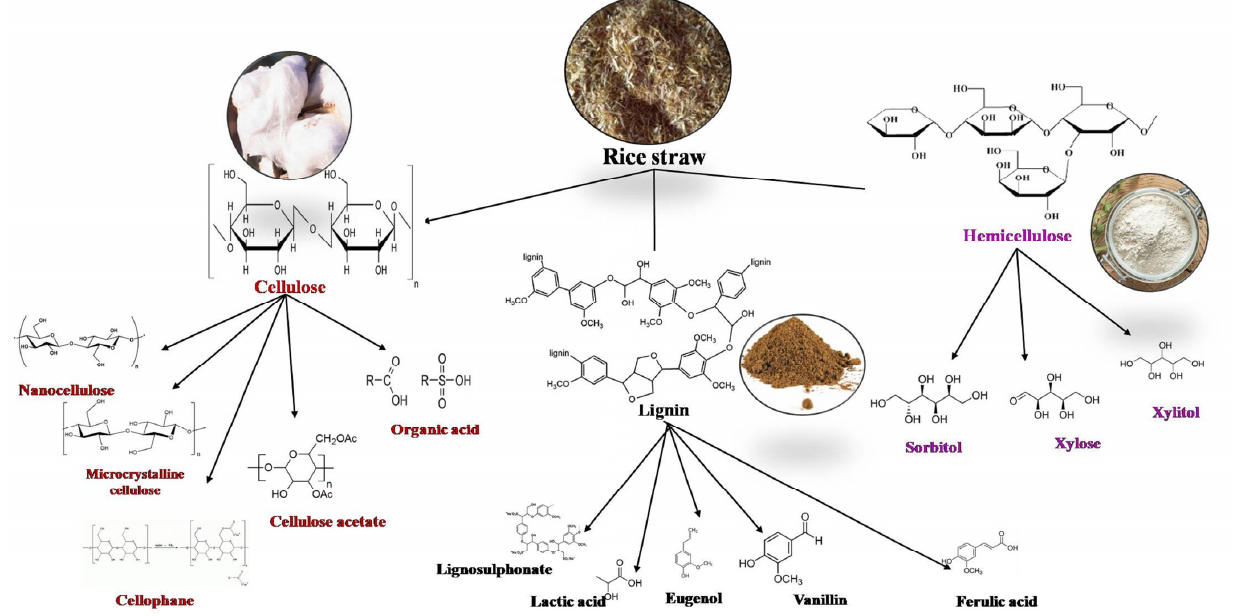
Figure 2. Chemical derived from different constituents of rice straw biomass.